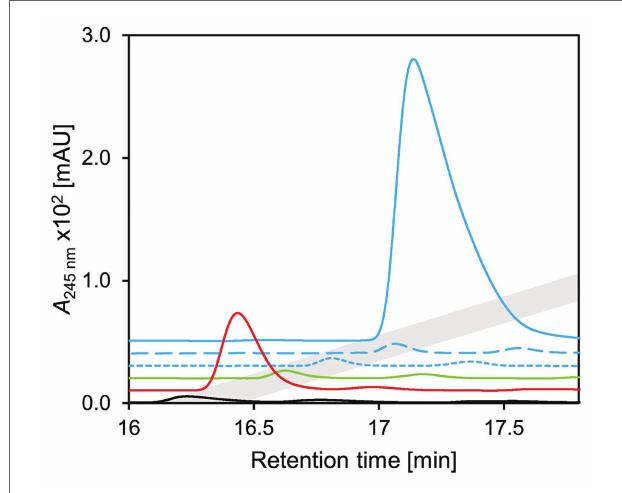
FIGURE 10 | UV-chromatograms of enzyme assays with 3-ketocholate ( 5 in Figure 2 ) as substrate, K 3 Fe(CN) 6 as electron acceptor and cell extracts of E. coli MG1655 pBBR1MCS5 carrying genes for homologs of 5 β - Δ 4 -KSTD1. Continuous blue 5 β -Δ4-kstd1 , dashed blue nov2c085 , dotted blue nov2c314 , all from Sphingobium sp. strain Chol11; green c211_11427 from P. stutzeri Chol1, red casH from Rhodococcus jostii RHA1, black empty vector control. Chromatograms are depicted with an offset in both retention time and intensity for easier distinction. Gray indicates retention time of Δ 4 -3-ketocholate ( 6 ). Enzyme assays were analyzed by HPLC-MS and steroid compounds were identified by their retention time, absorbance‐ and mass-spectrum.